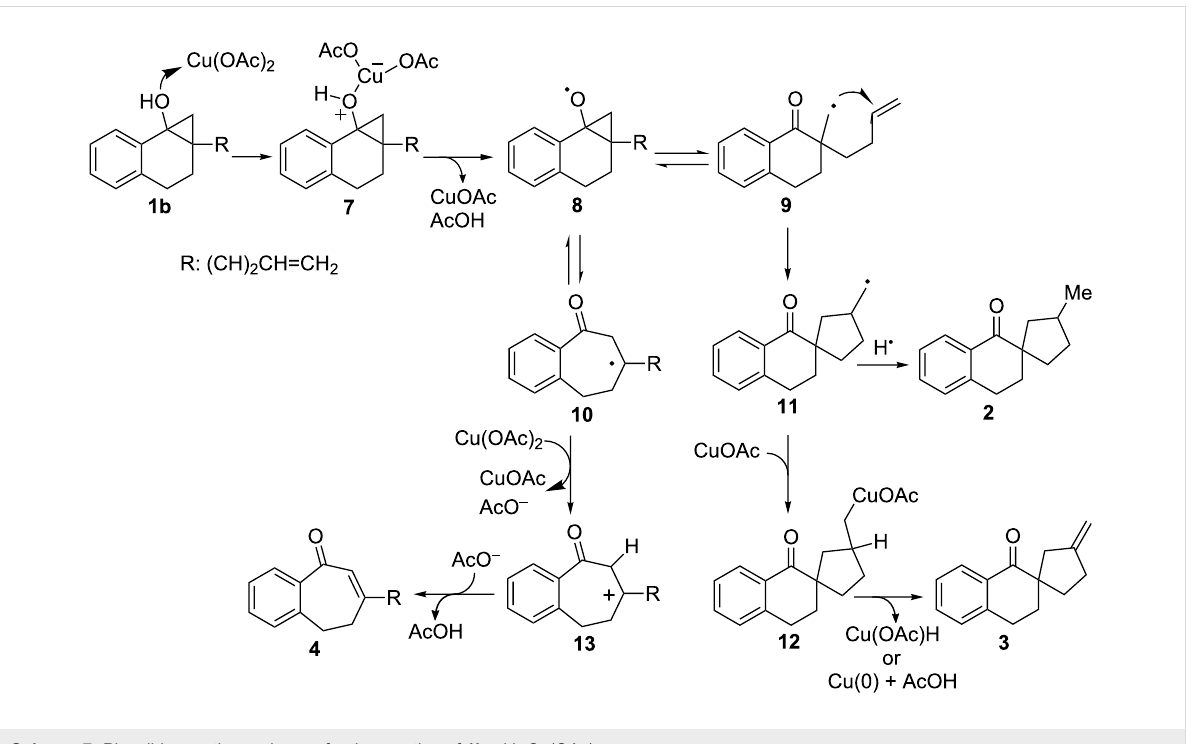
Scheme 7: Plausible reaction pathways for the reaction of 1b with Cu(OAc) 2